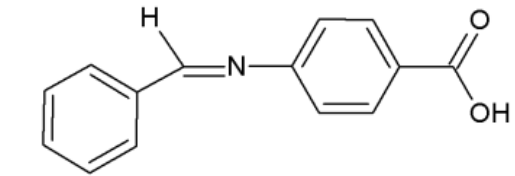
FIGURE 2 – Structural representation of 4-(benzylideneamino) benzoic